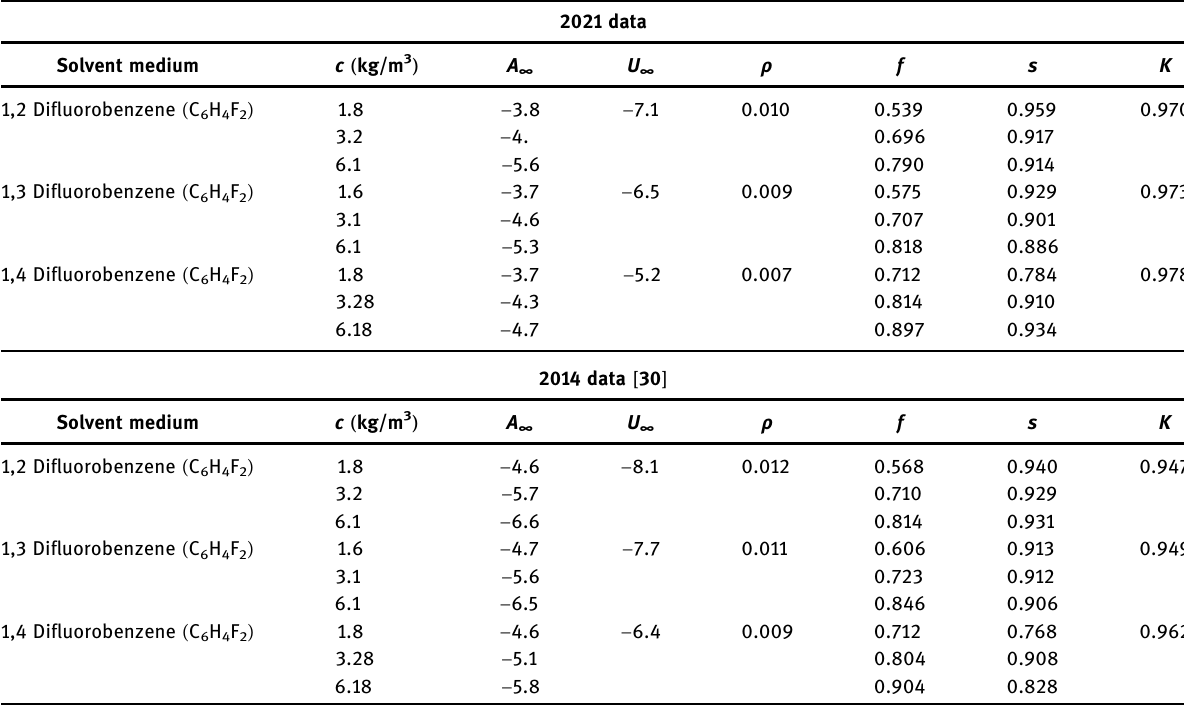
Table 3: DNP parameter values for the di fl uorobenzene isomer suspensions with MC800